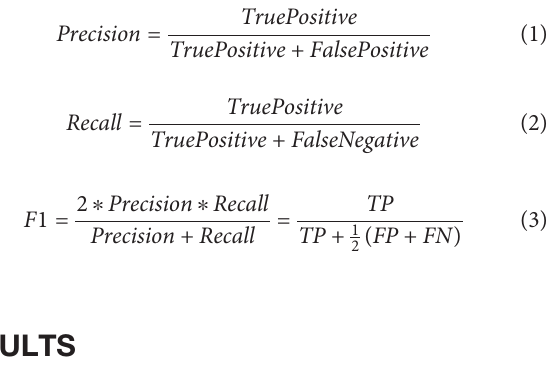
( Table 1A ). We quanti fi ed B-cells, T-cells, and monocytes including subsets and including CD4/CD8 activation and T- cell exhaustion. All T-cells determinations were initially gated on CD3 expression and all monocyte subsets were initially gated on CD45 ( Supplementary Figure 1 ). Unlike acute COVID-19 (4), the CD4 and CD8 T-cell populations in PASC were within